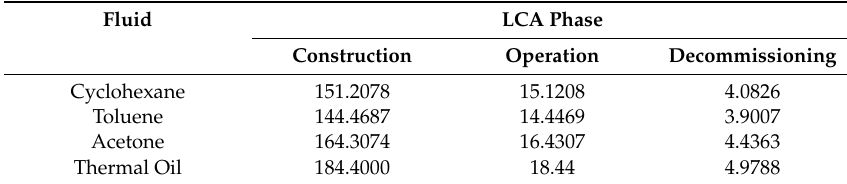
Table 3. Organic fluids and thermal oil masses in each life cycle phase.